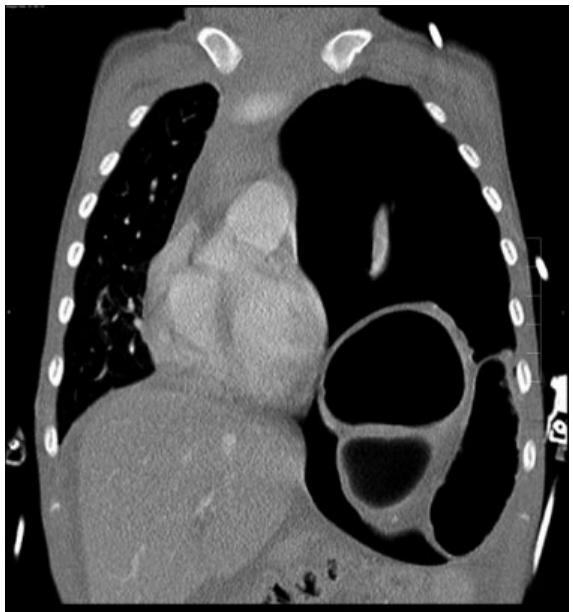
Fig.5 Gastric perforationafter repositioning of herniated organsinto the